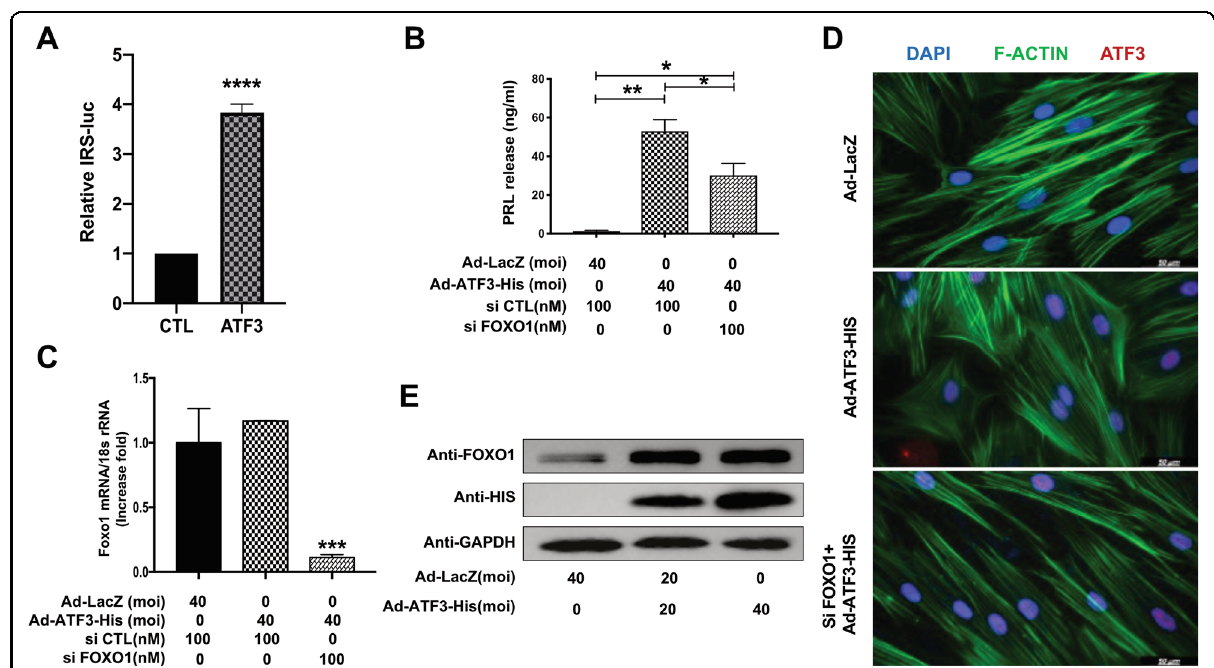
Fig. 4 ATF3 regulates decidualization mediated by FOXO1. A hESCs were treated with Ad-LacZ or Ad-ATF3-His for 48 h and transfected with IRS- luc and Rinella for dual-luciferase assays. **** P < 0.0001. B – D hESCs were transfected with Ad-ATF3-his (0 or 40 MOI) or Ad-LacZ. si-FOXO1 was used to knockdown the expression of FOXO1, and prolactin secretion was measured by an enzyme-linked fl uorescent assay (ELFA). * P < 0.05. Immuno fl uorescence was performed to analyze the morphological transformation of hESCs. Scale bar = 50 μ m. E hESCs were transfected with Ad- ATF3-his (0, 20, or 40 MOI) or Ad-LacZ. FOXO1 and His protein expression levels were measured by western